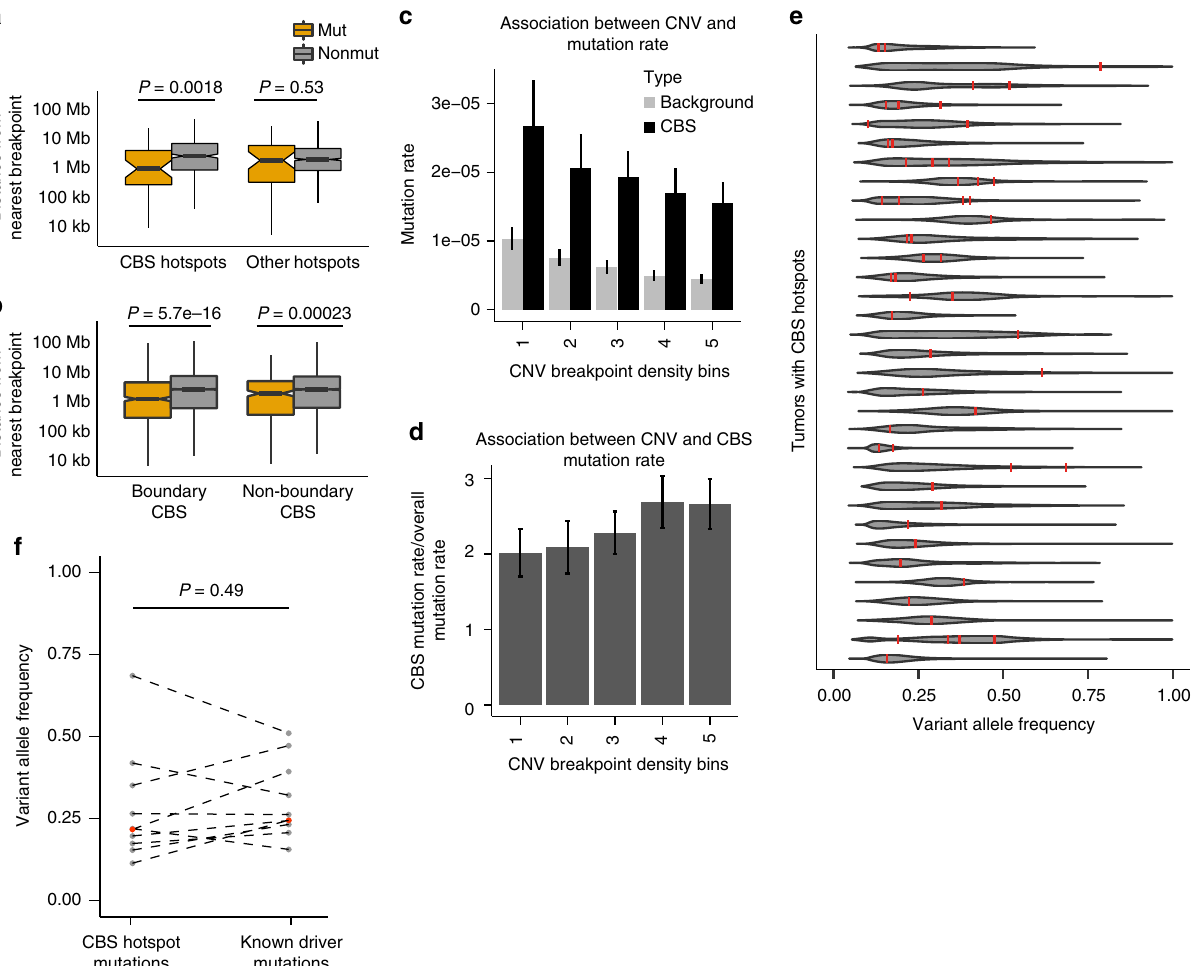
Fig. 7 Association between CBS mutations and genomic instability. a Distance to the nearest CNV breakpoint from CBS hotspots and other non-CBS mutation hotspots. b Distance to the nearest CNV breakpoint from CBSs at loop boundary and non-boundary CBSs. Wilcoxon rank-sum test P -values are shown. c Correlation of mutation rates with SCNA breakpoint density. d Correlation of normalized mutation rates with SCNA breakpoint density, correcting for the background mutation rate in each bin. Error bars represent the s.e.m. e The violin plots show the VAF distributions of somatic mutations in diploid regions of individual tumors. VAFs of the mutations at CBS hotspots are marked by red vertical lines. f Comparison between VAFs of the CBS hotspot mutations and VAFs of non-silent coding mutation on GC driver genes. The red points represent the median VAFs in each group. The dashed lines match mutations from the same samples. P -value is calculated by paired Wilcoxon rank-sum